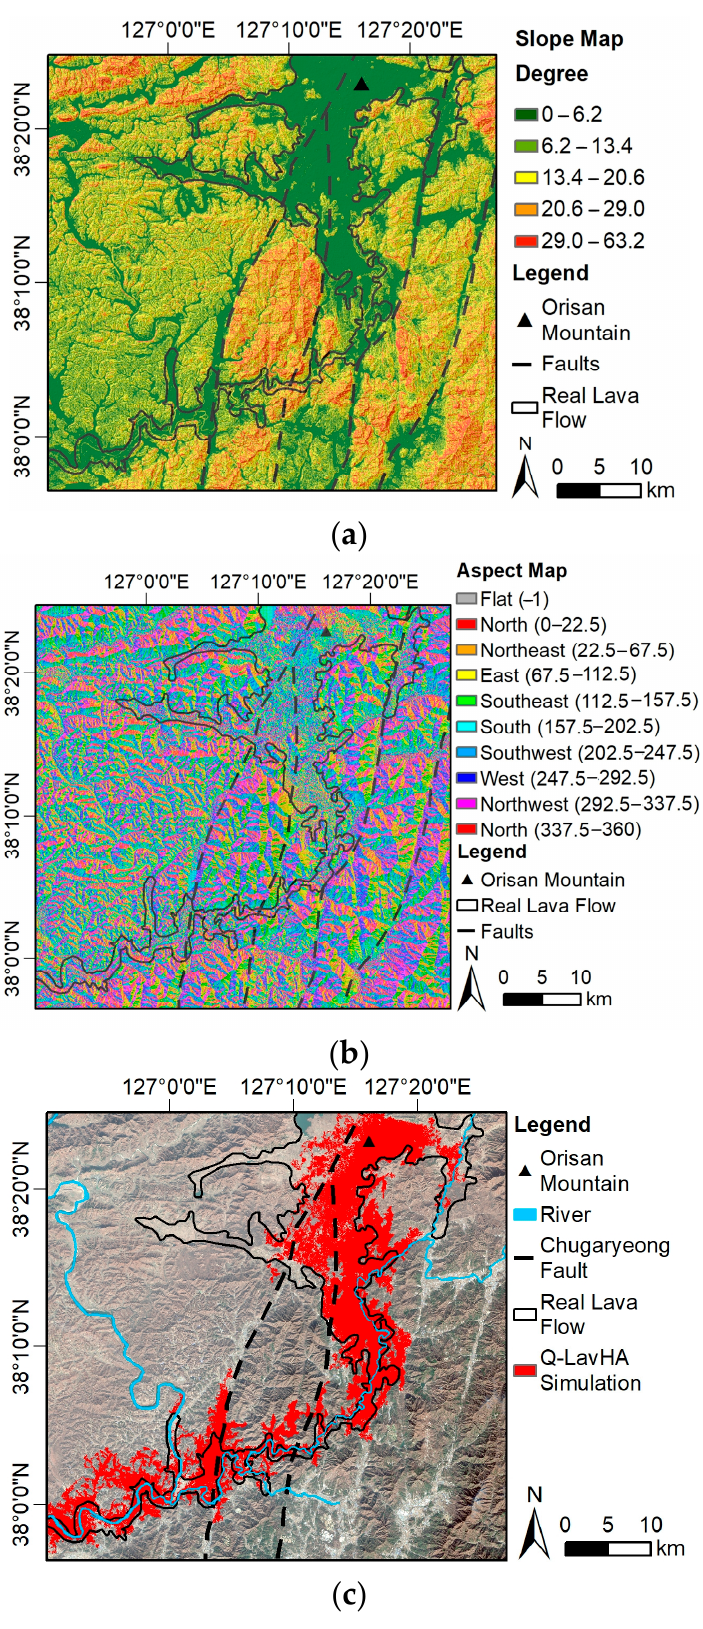
Figure 10. ( a ) Slope map; ( b ) aspect map; ( c ) Q-LavHA simulation of the multiple vent eruption case. Table 5. Probable eruptive vent proposed to simulate the multiple vent eruption.